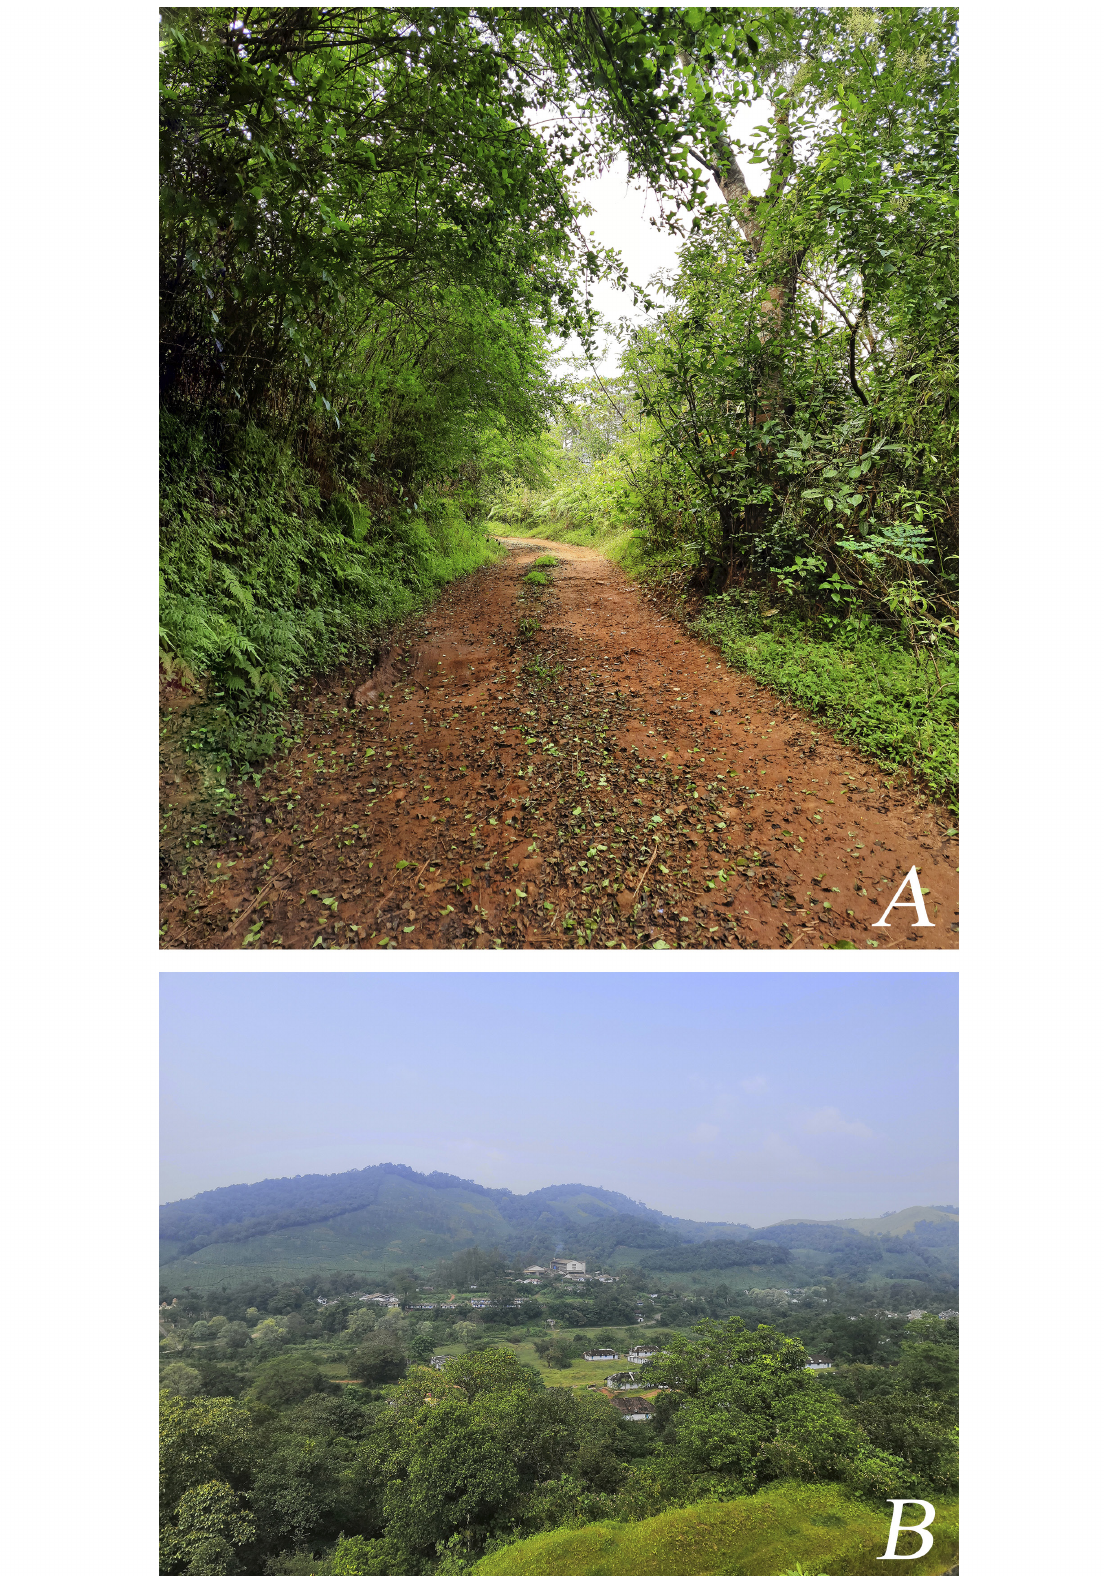
Fig. 12. Type locality of Isometrus nakshatra sp. nov. A . View of dense evergreen forest along road at the type locality. B . View of Kadmane Tea Estate with mountain range in southern Western Ghats,